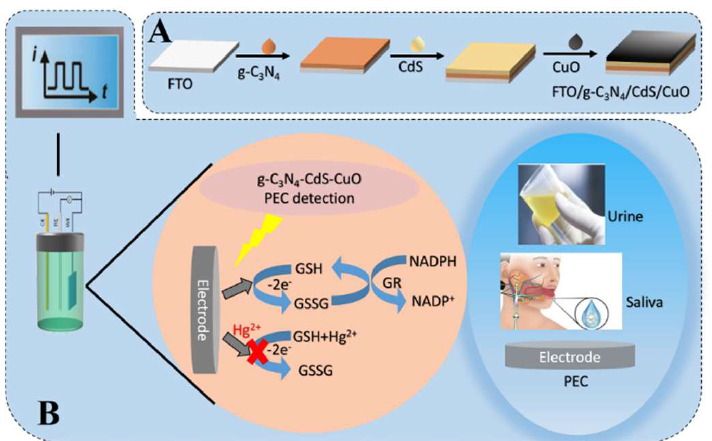
Scheme 1. Schematic diagram of electrode preparation process ( A ) and schematic diagram of redox cycle on photoanode of self-powered device and test in actual sample ( B ).